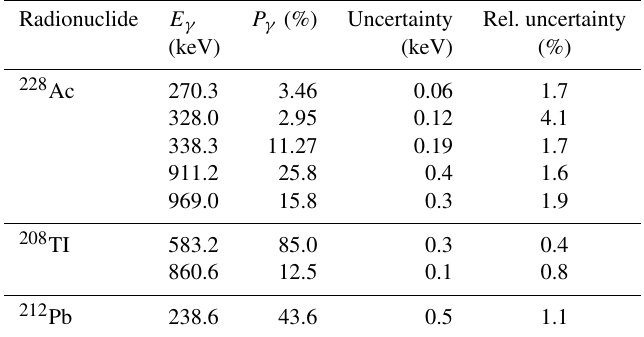
Table 3. Radioisotopes suitable for determining the 232 Th activity, their emission energies ( Eγ ), and emission probabilities ( Pγ ). Data are from the National Nuclear Data Centre (https://www.nndc.bnl.gov/, last access: 10 August